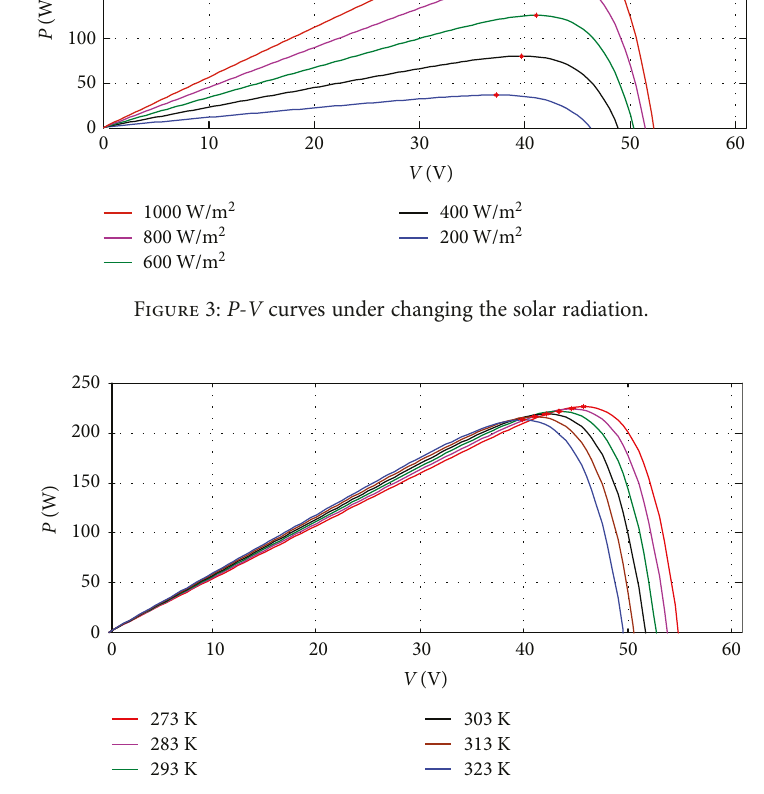
Figure 4: P - V curves under changing the temperature.